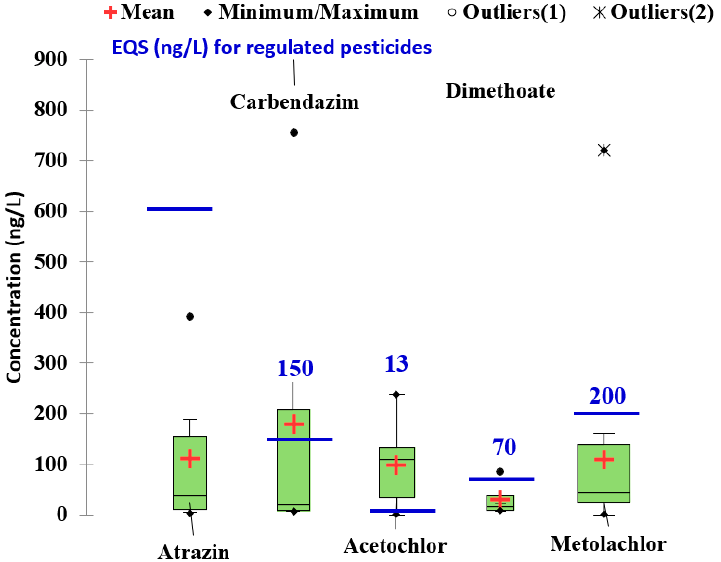
Figure 4. Variation of common pesticides in surface waters of Lower Danube basin compared to the PNEC values, according to the NORMAN Prioritization